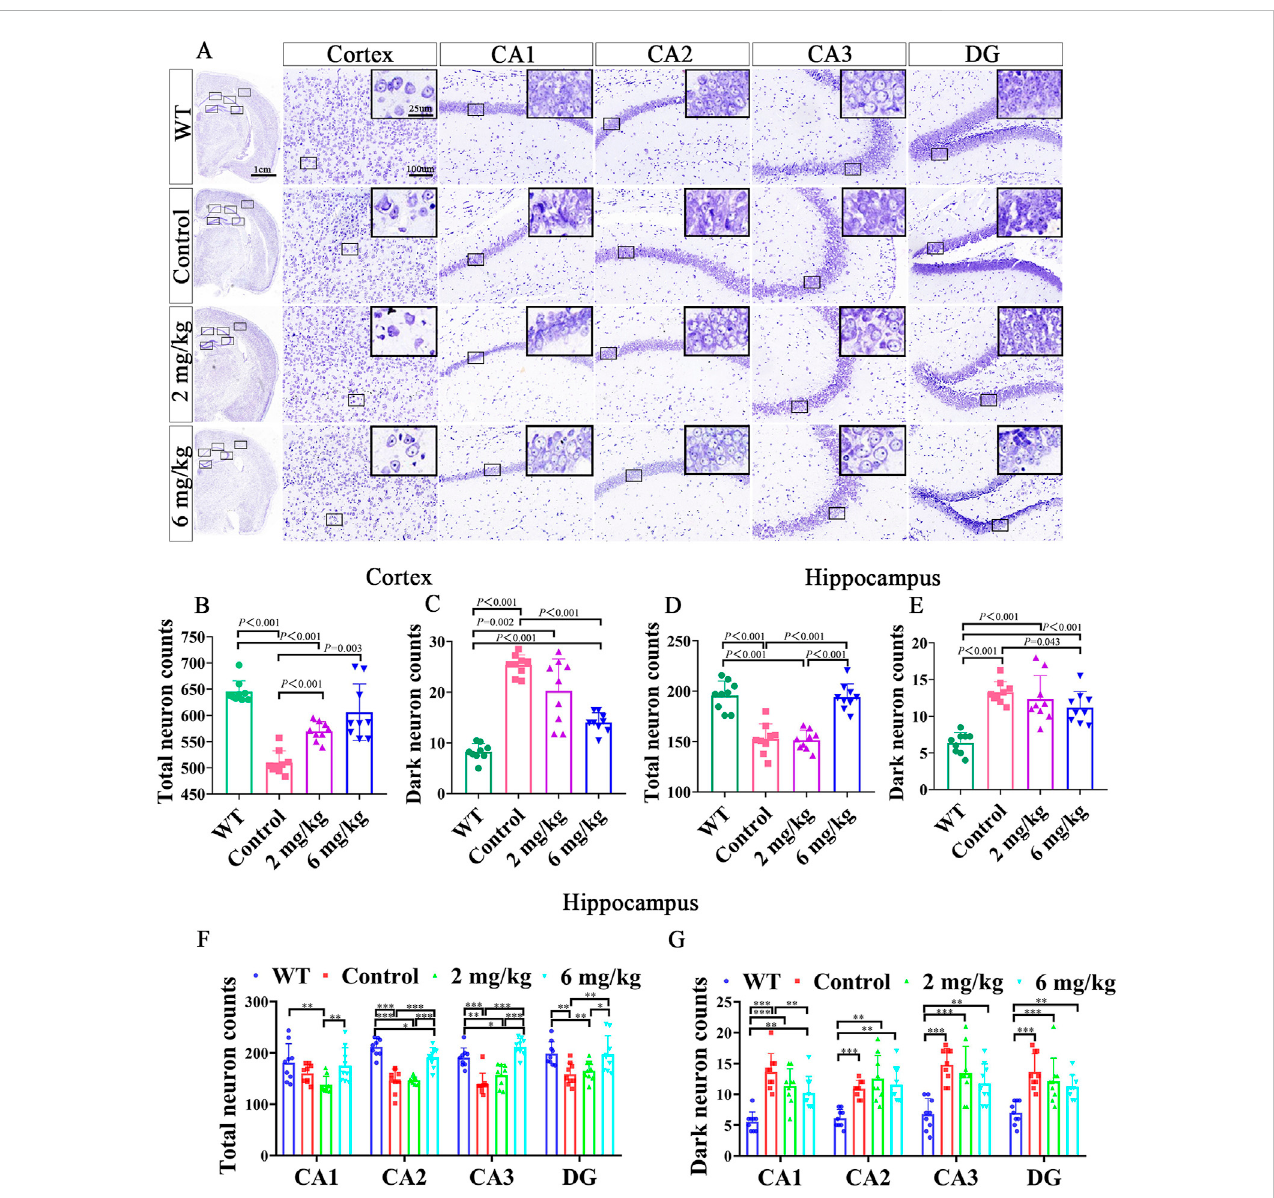
FIGURE 3 Nissl staining of the brain after gavage treatment for 1 month. After gavage treatment for 1 month, total surviving neurons increased, and dark neurons decreased(DG,dentategyrus;CA,cornuammonis)( n =3,eachmouseprovidesthreedata,dataareexpressedasmean±standarddeviation). (A) Nisslstaining of the cortex and hippocampus in WT, control, 2 mg/kg, 6 mg/kg group. (B) Quantitative histogram of cortical total surviving neuron statistics in mice. (C) Quantitative histogram of cortical dark neuron statistics in mice. (D) Quantitative histogram of hippocampal total surviving neuron statistics in mice. (E) Quantitative histogram of hippocampal dark neuron statistics in mice. (F) Histogram of surviving total neurons in different subdivisions of the mouse hippocampus. (G) Histogram of dark neurons in different subdivisions of the mouse